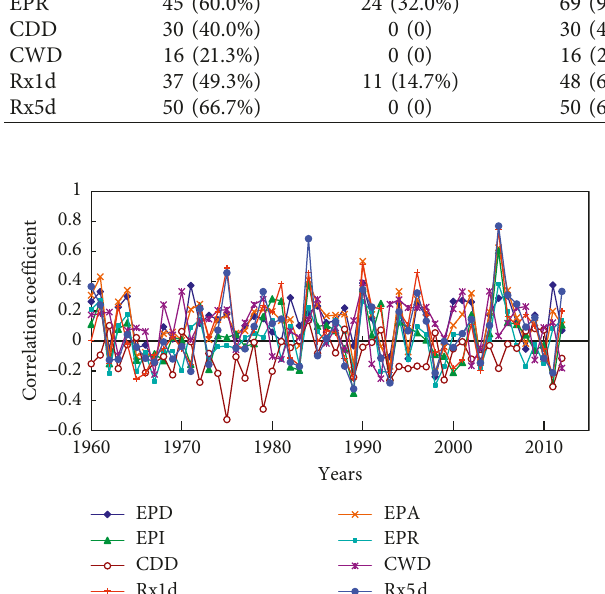
Figure 8: Variation of correlation coefficients between the extreme precipitation indices and